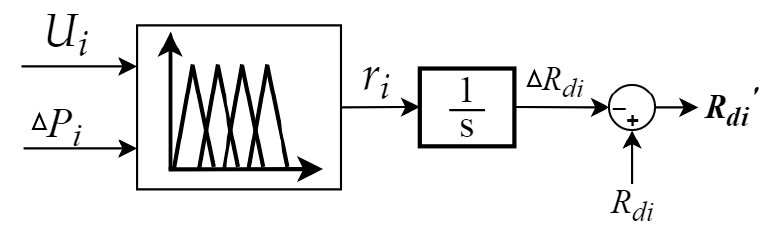
Figure 5. The fuzzy logic controller.